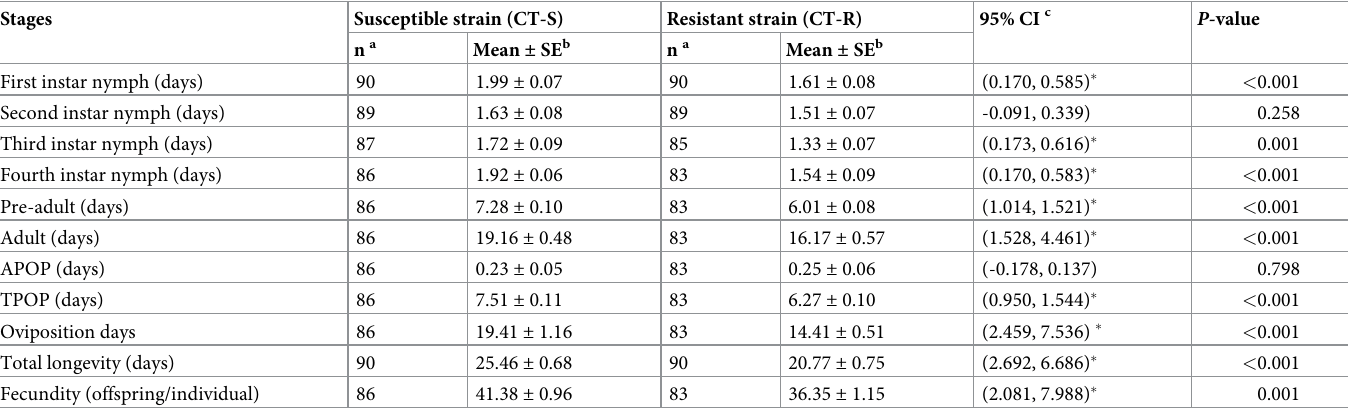
Table 2. Mean ( ± SE) life history parameters of the susceptible (CT-S) and resistant (CT-R) strains of Aphis gossypii